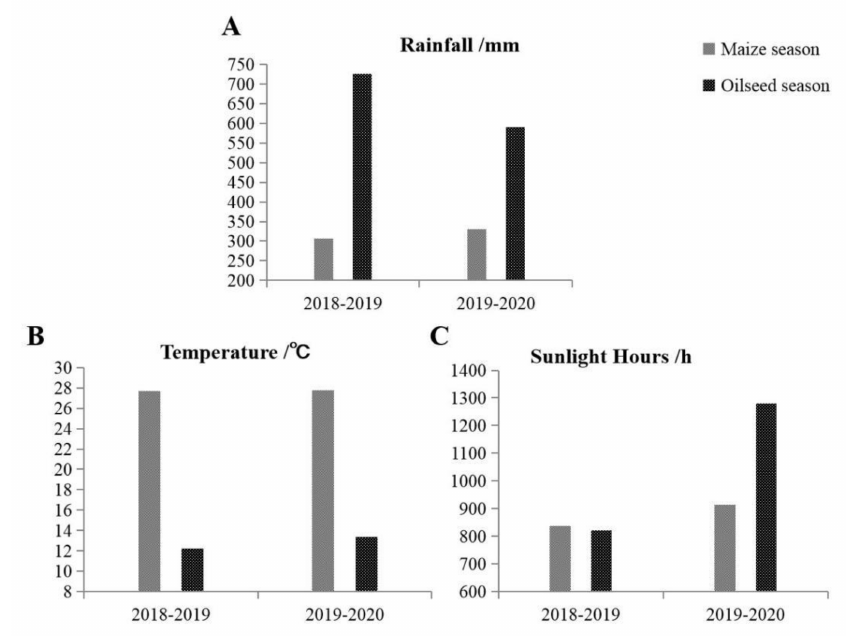
Figure 2. Basic meteorological data of the experimental site during experimental period. ( A ): Rainfall; ( B ): Temperature; ( C ): Sunlight